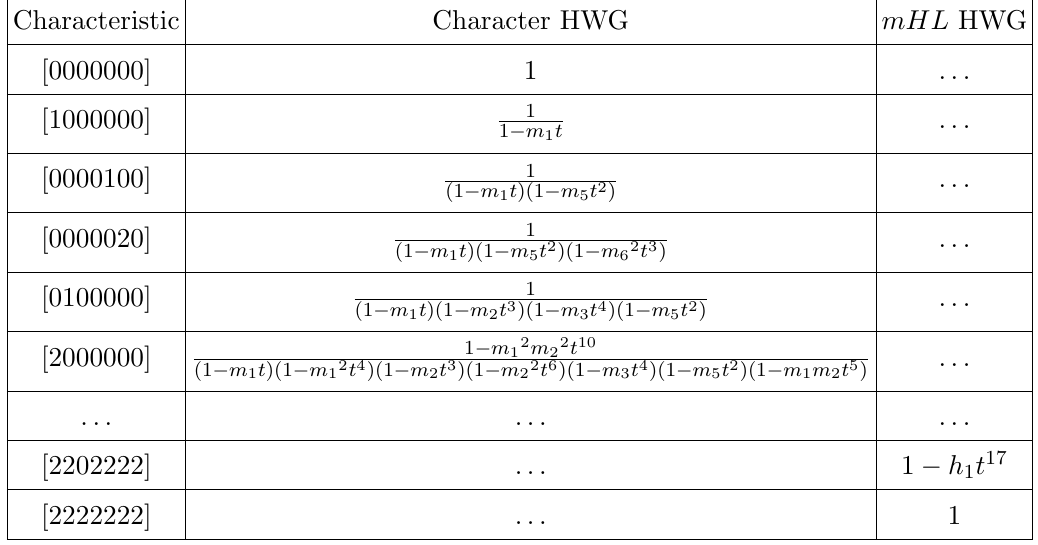
( t ). Orbits in the [0000000]